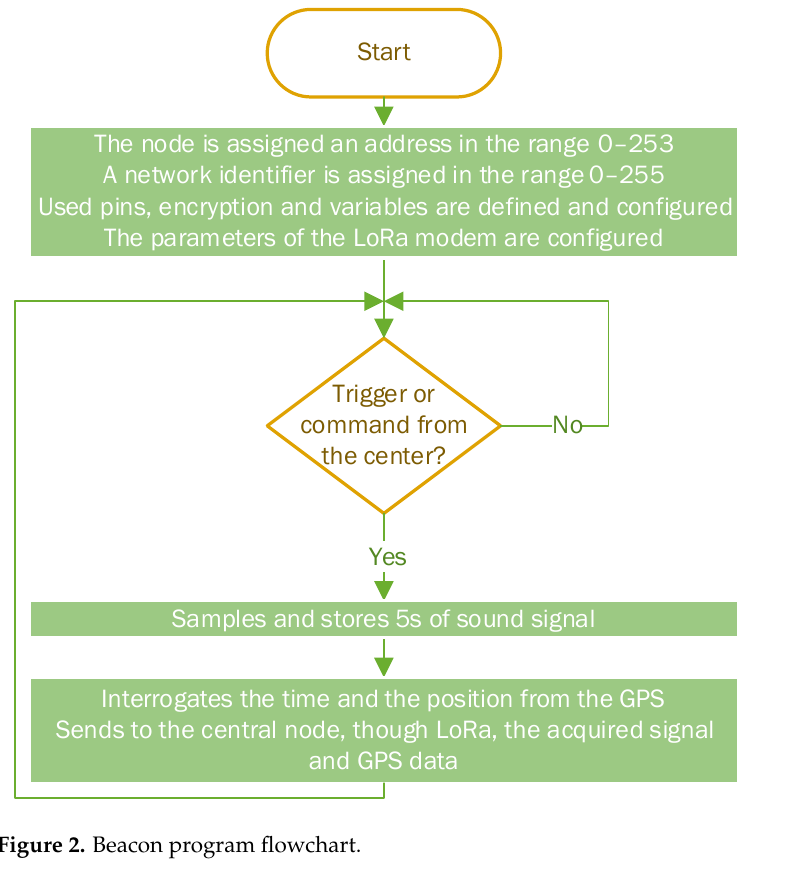
Figure 2. Beacon program flowchart.